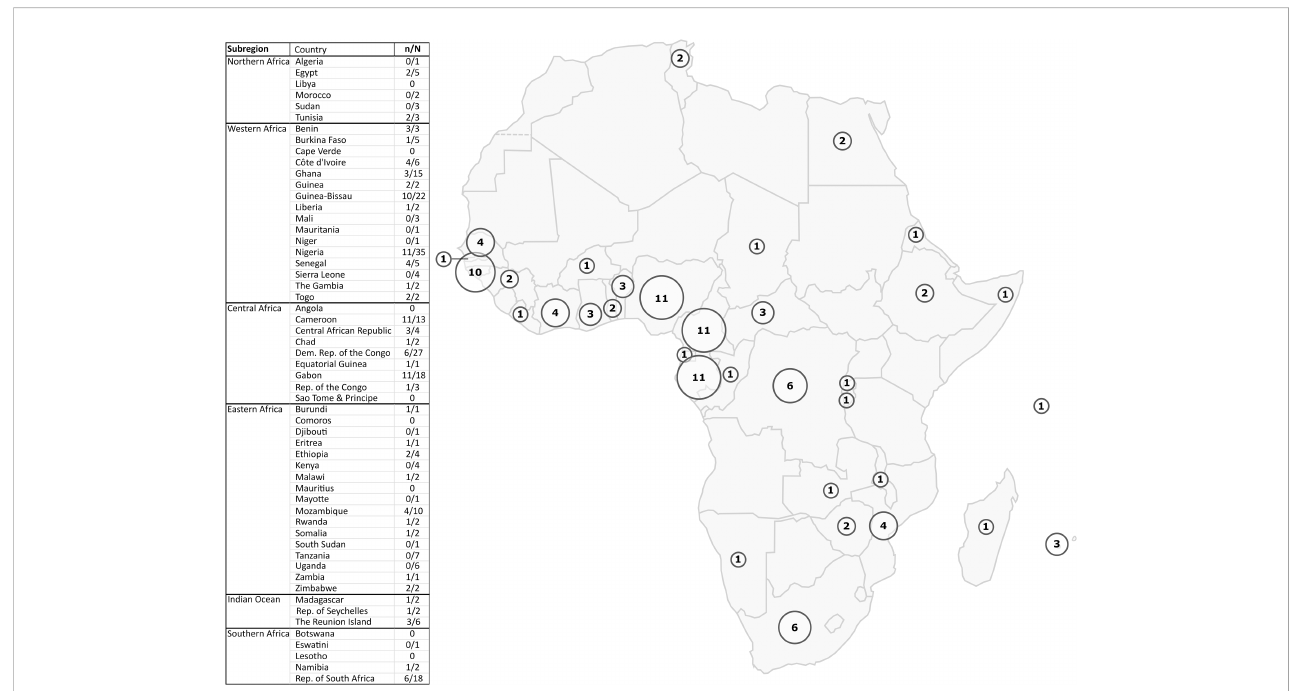
FIGURE 3 Map of Africa showing the geographic location of HTLV-1 prevalence studies. The circles represent the number of HTLV-1 prevalence studies among blood donors, pregnant women, or the adult rural or urban population in each country that were included in the representation of results. For each country, the n/N column of the table indicates the number of included studies out of the total number of HTLV-1 epidemiological studies concerning that country. Studies with data on different countries were counted for each concerned country (i) both in the number of included studies (ni) and in the total number of studies (Ni). As a result, the sum of ni for all countries is greater than the total number of studies included in our study (n). The same is true for the total number of studies. The exclusion criteria are detailed in Figure 2.